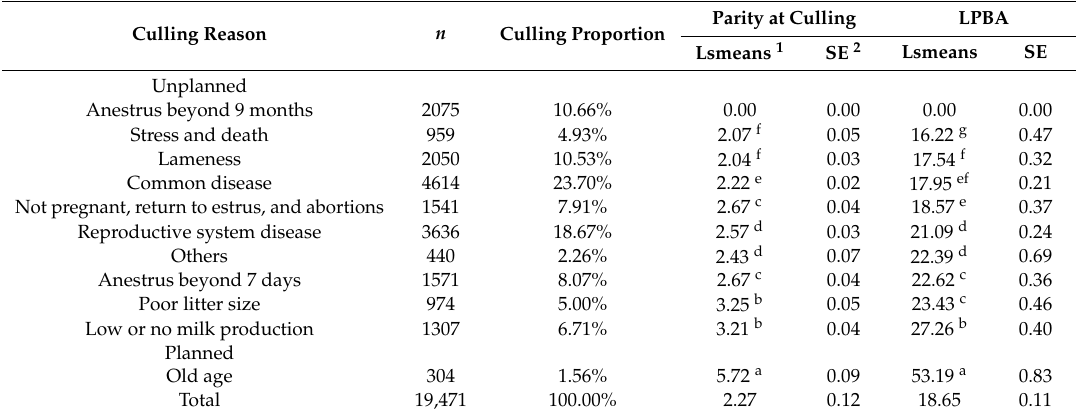
Parity at Culling LPBA